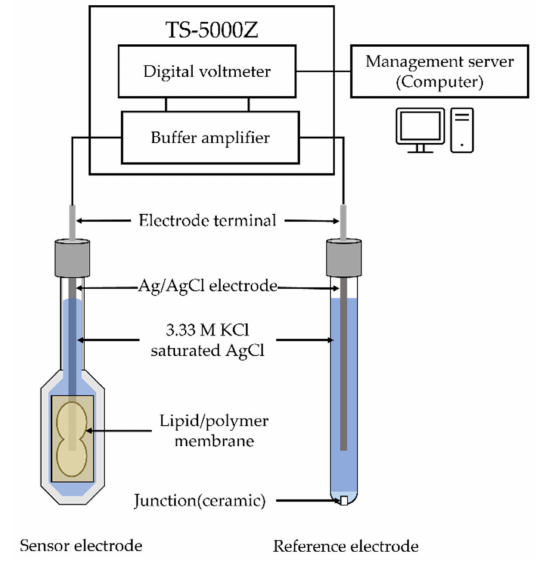
Figure 2. The diagram of taste sensing